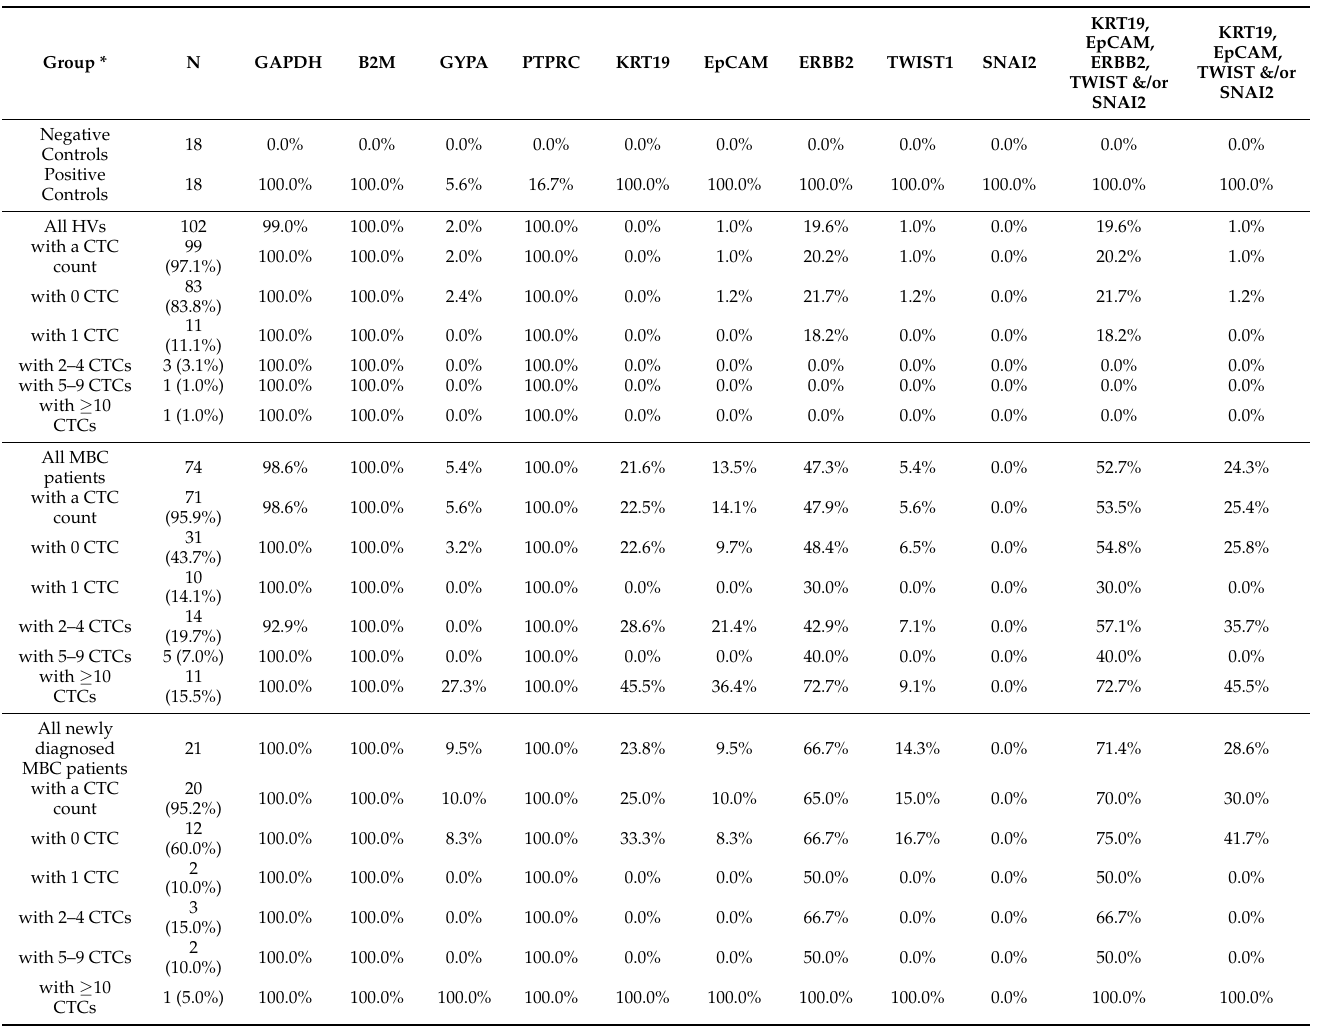
Table 4. Proportions of HV subjects and MBC patients with positive gene expression using a Ct value threshold of ≤ 35.0 for each gene to determine positivity and comparisons to numbers of CTCs observed on Wright-Giemsa-stained slides during cytopathology